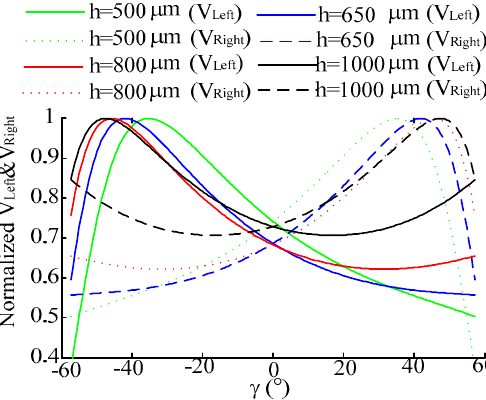
Figure 11. Normalized characteristic curve of V Right and V Left when changing γ . ( h is 500 μ m, 650 μ m, 800 μ m, 1000 μ m, respectively, and keeping p = 0 μ m and α = 20° constant).